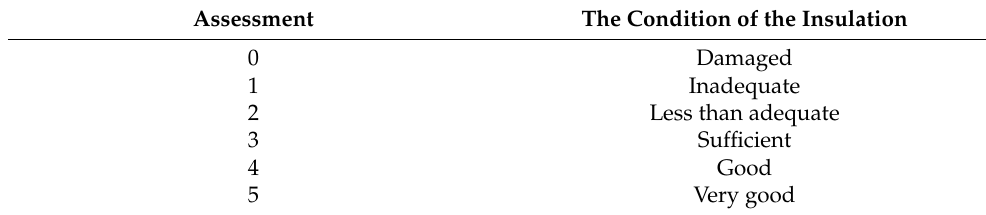
Table 8. Score assessment in the WMPS method.